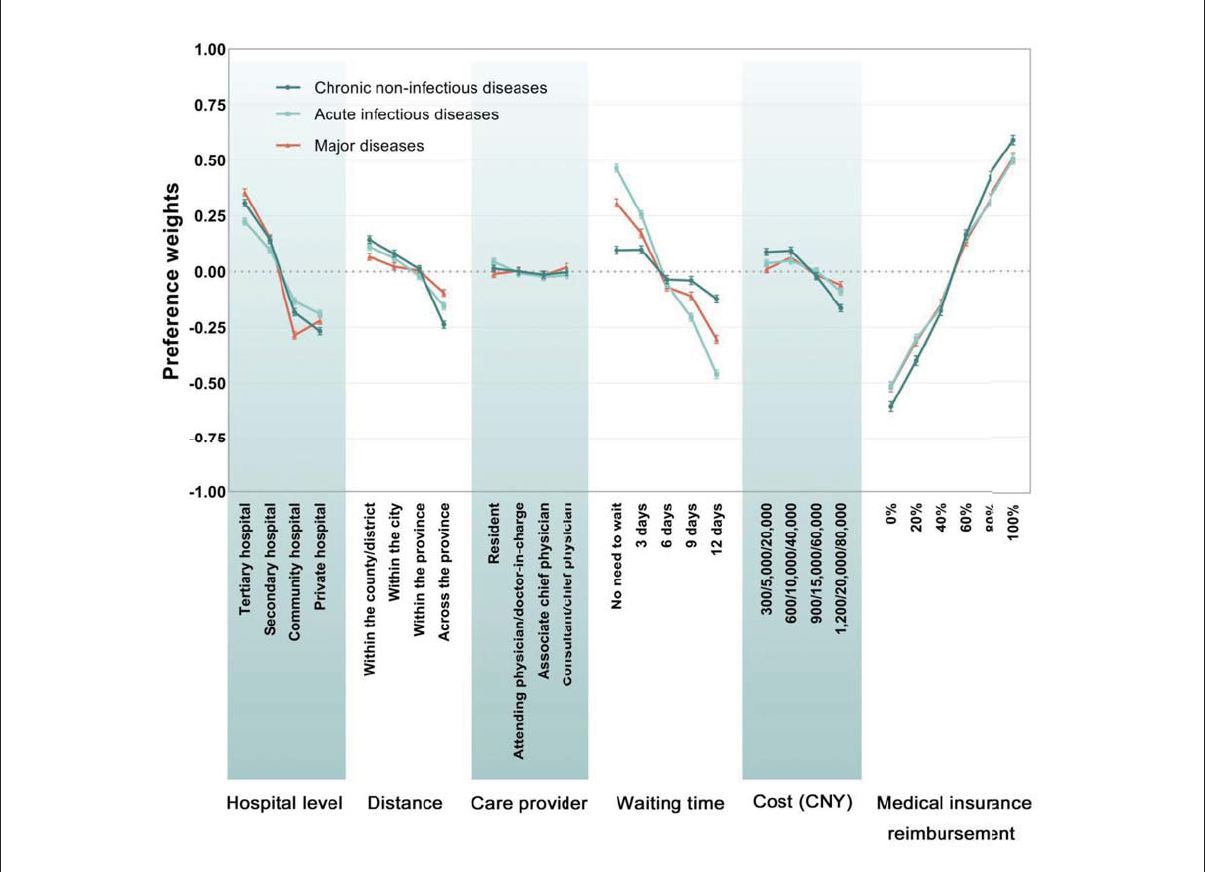
FIGURE2 Preference weights